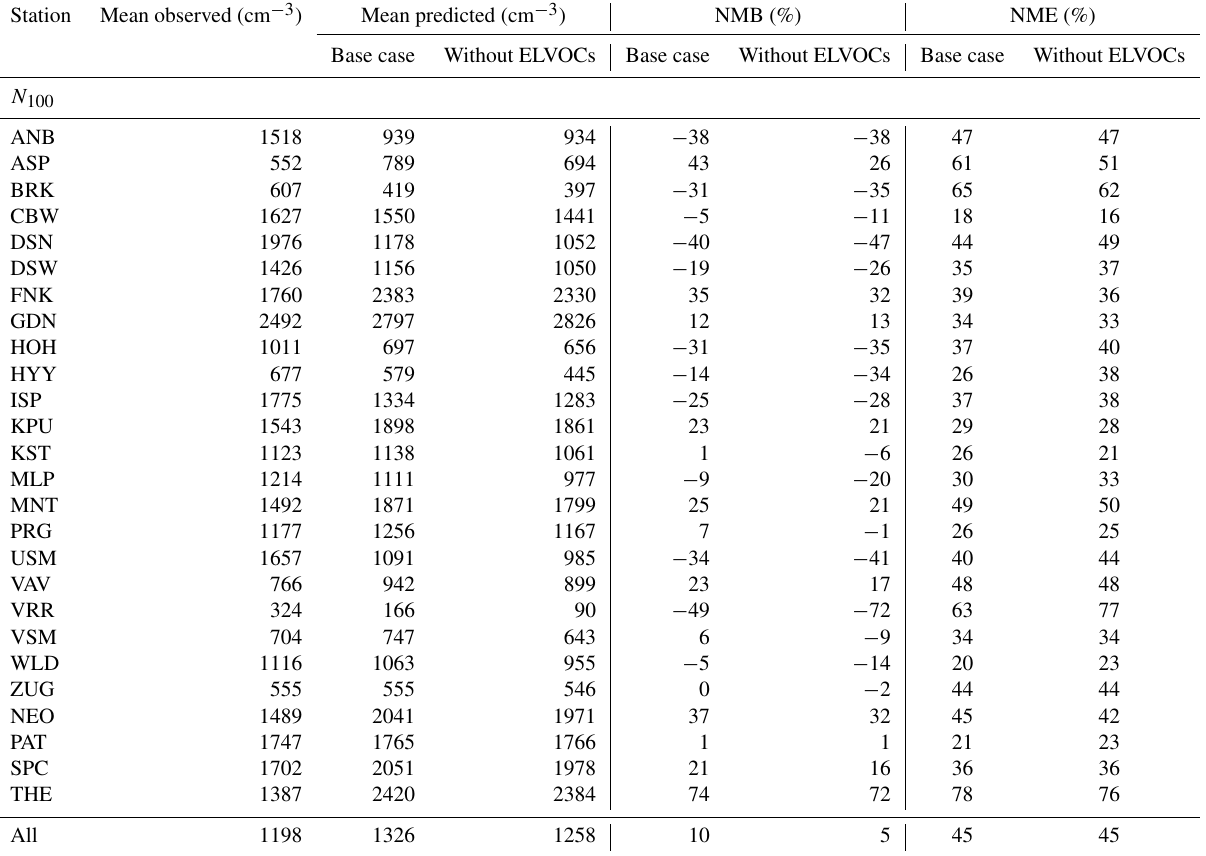
Table 3. Prediction skill metrics of PMCAMx-UF against daily ground measurements of particle number concentration above 100nm ( N 100 ) from 5 June–8 July 2012.